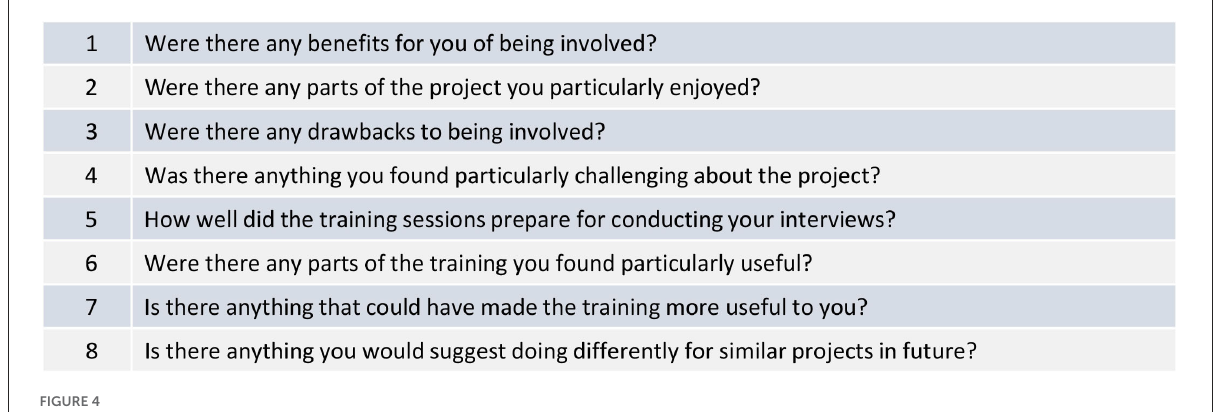
FIGURE4 Examples of orienting